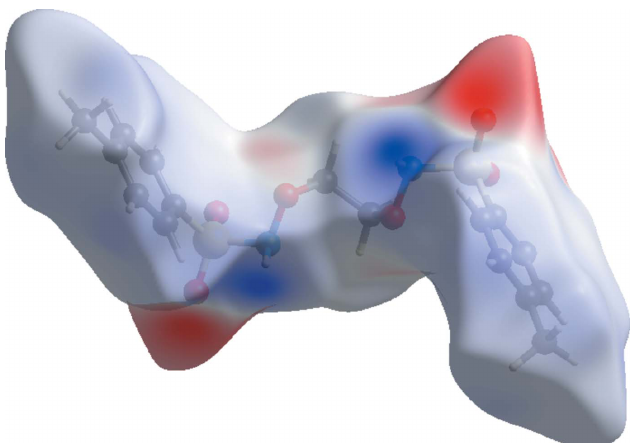
Figure 8 A view of the three-dimensional Hirshfeld surface plotted over electrostatic potential